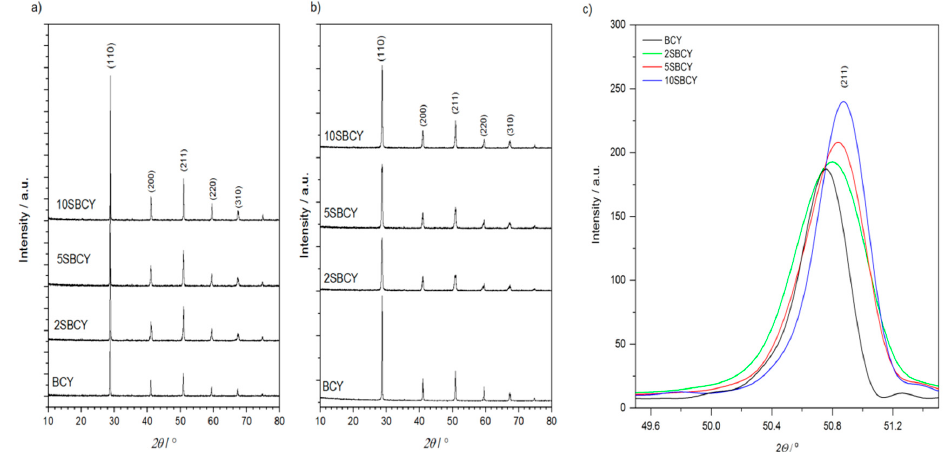
Figure 1. XRD patterns collected for Ba 1–x Sr x Ce 0.9 Y 0.1 O 3– δ (0 < x < 0.1) (SBCY) powders ( a ),